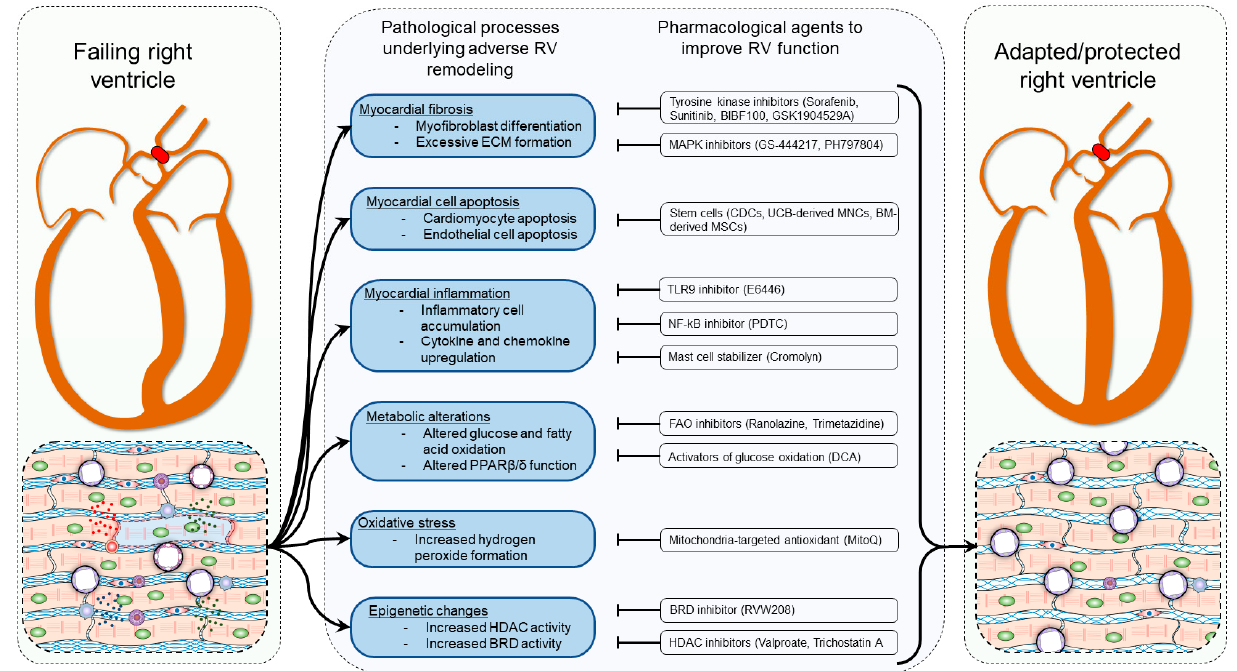
Figure 7. Main pathological features of right ventricular (RV) remodeling and main signaling pathways targeted to improve RV adaptation and protection in response to pressure overload. Upon exposure to pressure overload, the RV undergoes changes such as RV wall hypertrophy and dilatation, associated with various pathological processes including myocardial fibrosis, apoptosis of myocardial cells, myocardial inflammation, oxidative stress, metabolic remodeling, and alterations of epigenetic processes. Targeting the signaling pathways driving such changes improves RV function and adaptation to pressure